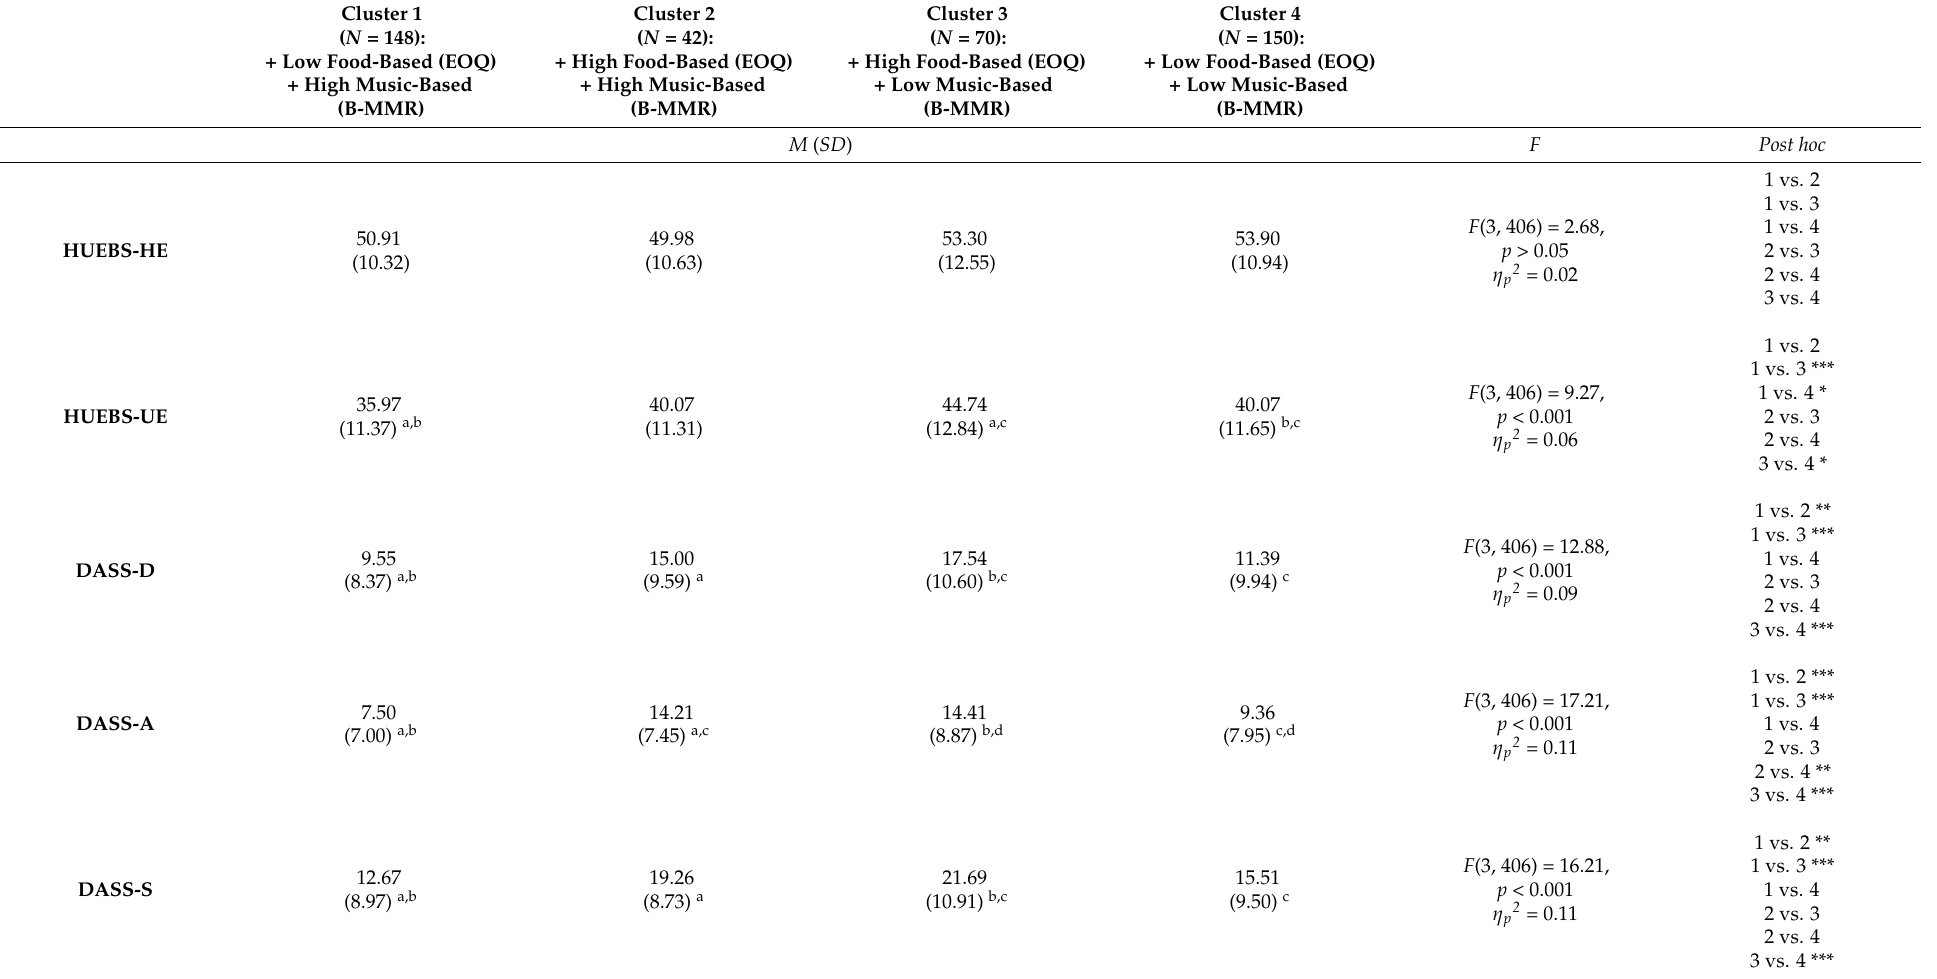
Table 2. Separate univariate ANOVAs on the outcome